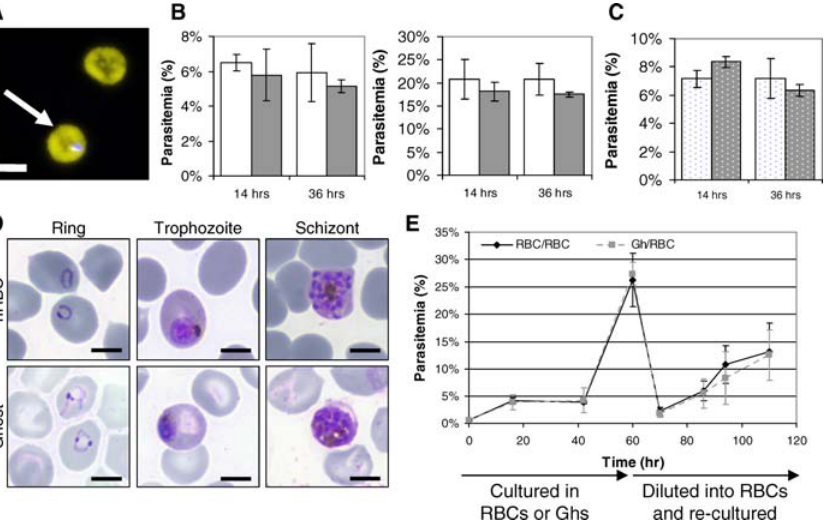
Figure 3. Erythrocyte Ghosts Support Malarial Invasion and Growth (A) LY-D–loaded erythrocyte ghosts (yellow) were infected with P. falciparum (detected by blue DNA stain Hoechst 33342; indicated by arrow). Bar represents 5 l m. (B) Ghosts (white bars) or erythrocytes (grey bars) infected at low (left) or high (right) parasitemias were monitored by Giemsa staining of thin blood smears at the indicated times of infection; mean values are shown. Error bars show standard deviation of triplicate measurements of a representative experiment. (C) An infected culture containing 50% ghosts and 50% erythrocytes was monitored for cell type-specific parasitemias by counting the number of Hoechst 33342–stained parasite nuclei in fluorescent ghosts (white bars) versus non-fluorescent erythrocytes (grey bars) using DIC and fluorescence microscopy of live cells (see Methods). Error bars show standard deviation of triplicate measurements of a representative experiment. (D) Giemsa-stained thin blood smears showing ring-, trophozoite-, and schizont-stage parasites in normal (upper) and ghosted (lower) erythrocytes. Bar represents 5 l m. (E) Growth of P. falciparum in ghosts (Ghs) or in erythrocytes (RBCs) in culture over multiple life cycles. Parasites were cultured in ghosts (indicated by dashed line) or in normal erythrocytes (indicated by solid line) for 60 h to ; 25% parasitemia, and then were diluted into normal erythrocytes and grown for an additional 50 h. Parasitemia was assessed by counting Giemsa-stained thin blood smears. Error bars show 95% CIs of duplicate measurements at each time